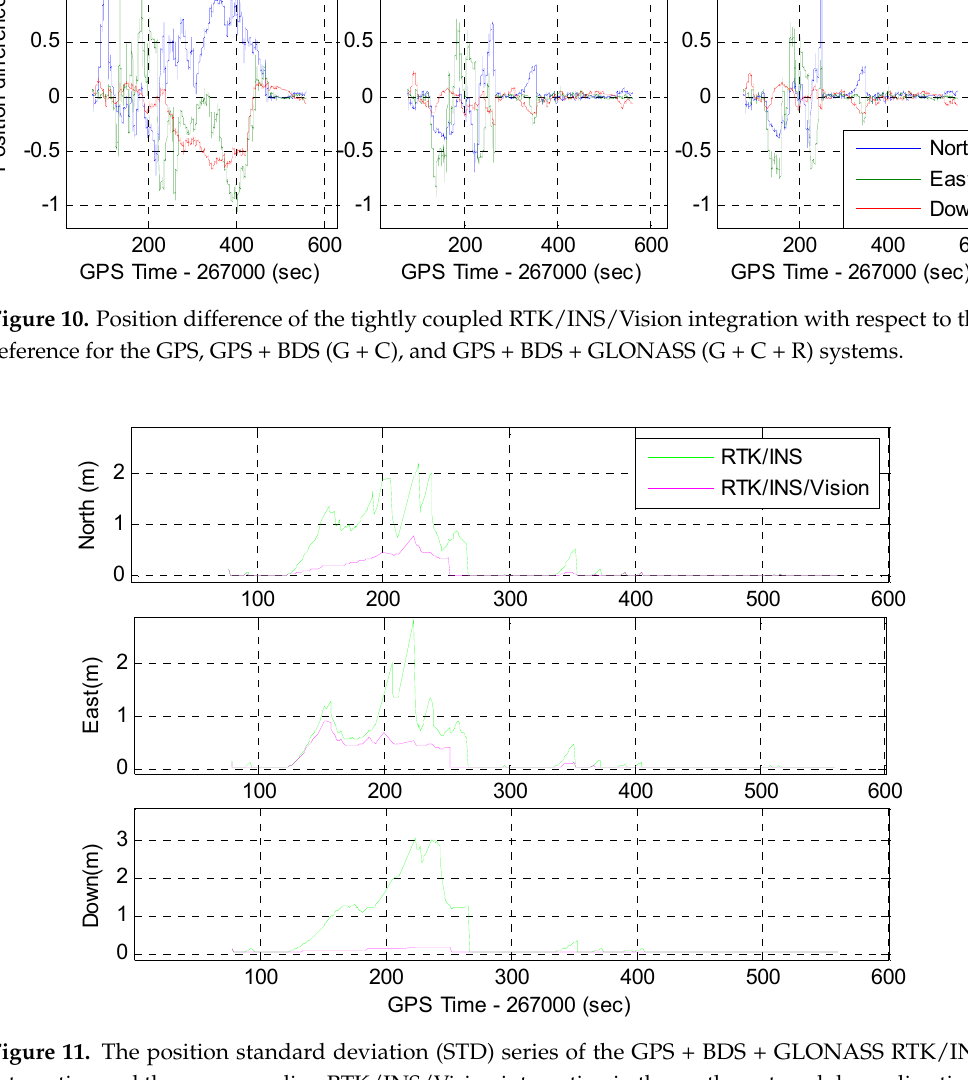
Figure 11. The position standard deviation (STD) series of the GPS + BDS + GLONASS RTK/INS integration and the corresponding RTK/INS/Vision integration in the north, east, and down directions. The STDs are the square roots of the corresponding diagonal elements of the state covariance matrix and the values have been transformed from the e-frame into the north–east–down frame.